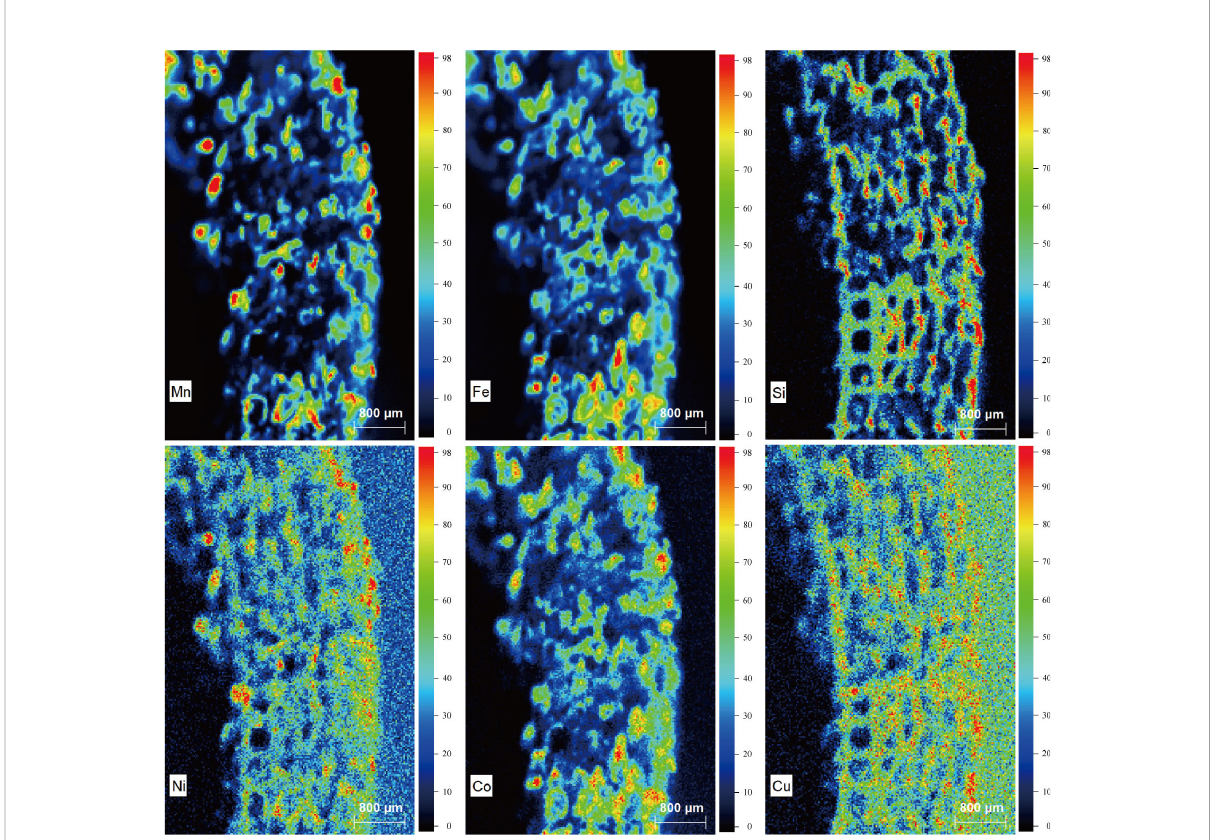
FIGURE 4 Major elemental distribution of FMP. Intensities are indicated by the color index at the right of each illustration. Mn, Fe, Ni and Co are of hydrogenetic origin and Si and Cu are of biogenic